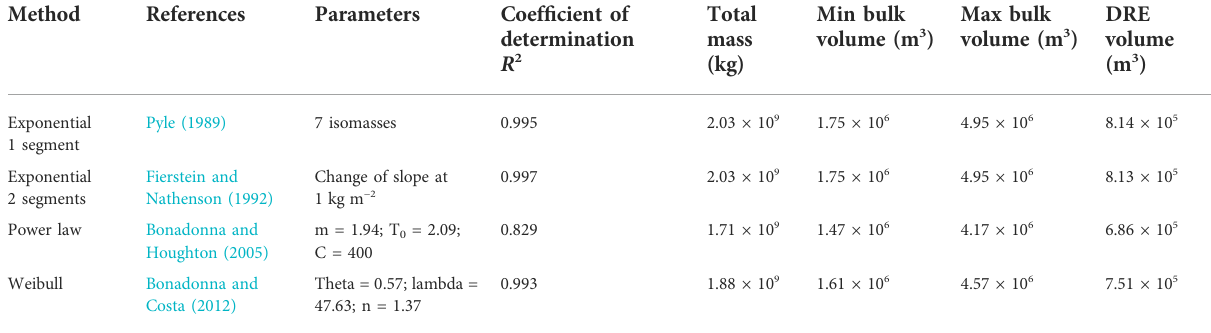
TABLE 3 Mass, bulk and DRE volumes of the ash fallout. Minimum (Min) and Maximum (Max) bulk volumes are calculated using maximum and minimum deposit density. Dense-rock equivalent (DRE) volume was calculated using a 2500 kg/m 3 density for andesitic magmas (Crosweller et al., 2012).